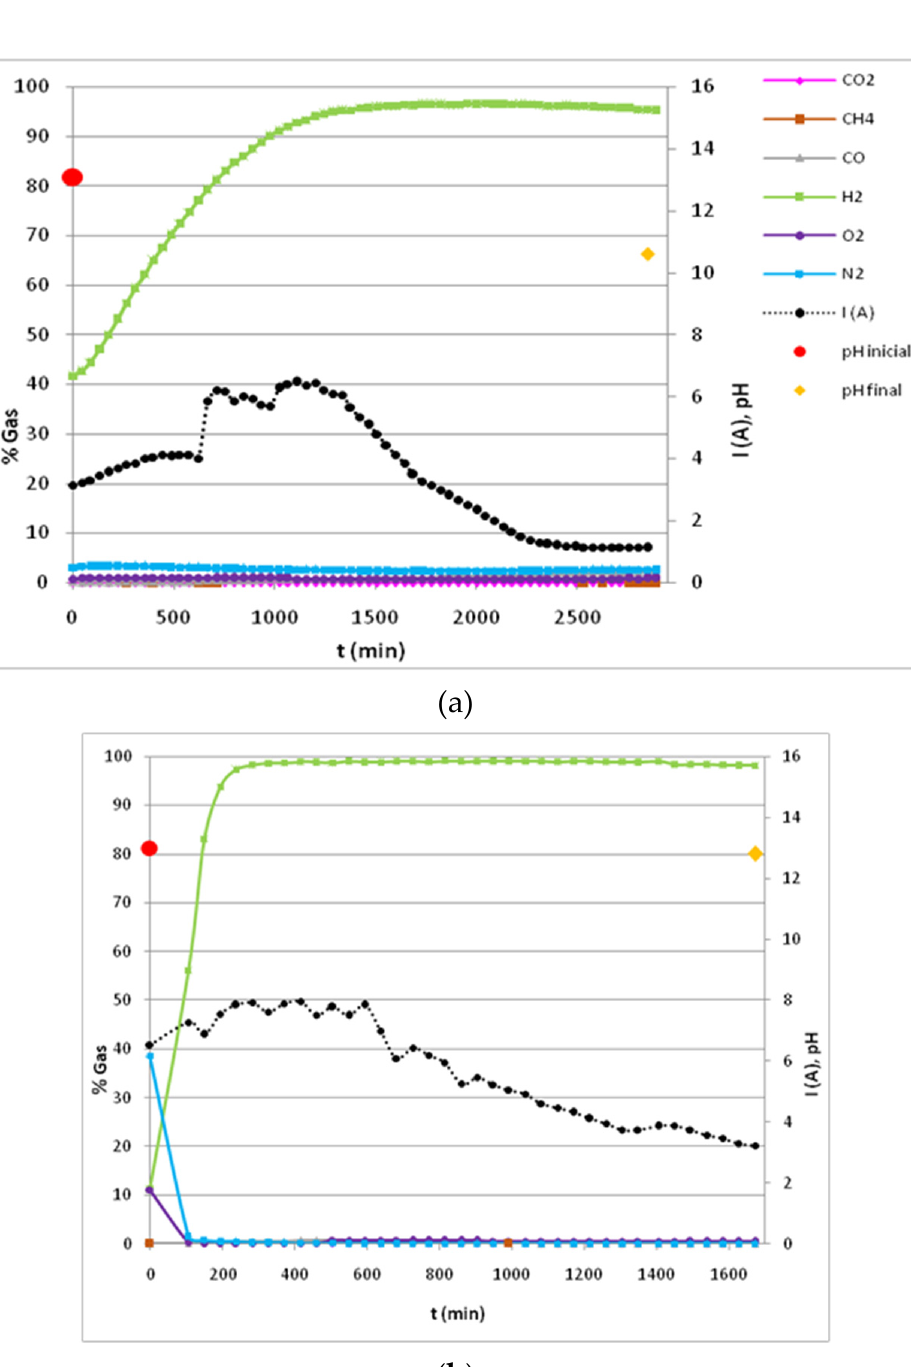
Figure 8. Temporal evolution of generated gases (%) and current in the alkaline electro-oxidation, at 3 V, of: ( a ) biodiesel wastewater 3 M, KOH 1.5 M, 8 mm thickness electrodes; ( b ) biodiesel wastewater 3 M, KOH 1.5 M, 16 mm thickness electrodes.